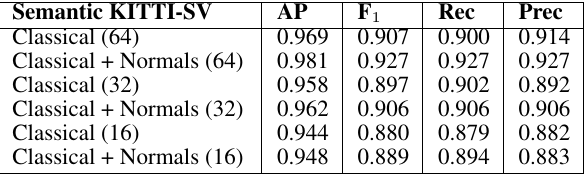
Table 3. Results obtained on the test set of the Semantic-KITTI dataset in the